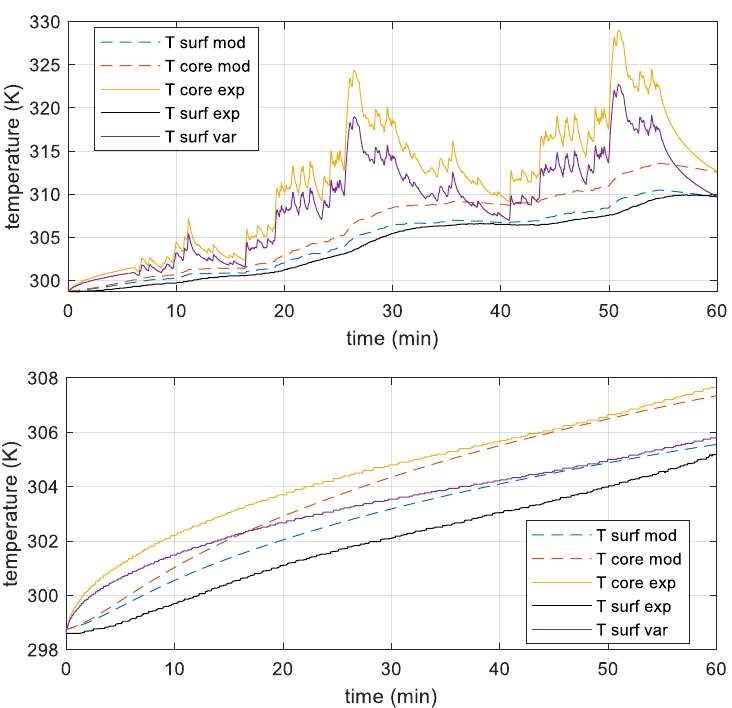
Figure 10. Comparison between experimental data and model simulation: tests number 2 ( first plot) and 3 ( second plot).